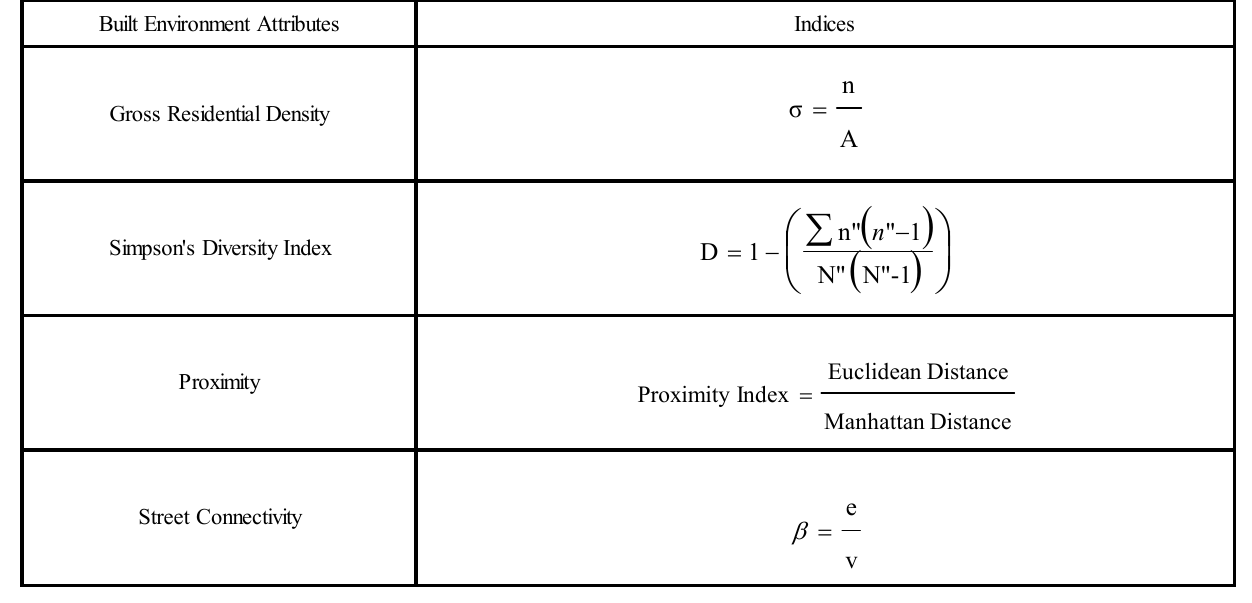
TABLE 1. INDICES USED FOR OBJECTIVE ASSESSMENT OF BUILT ENVIRONMENT